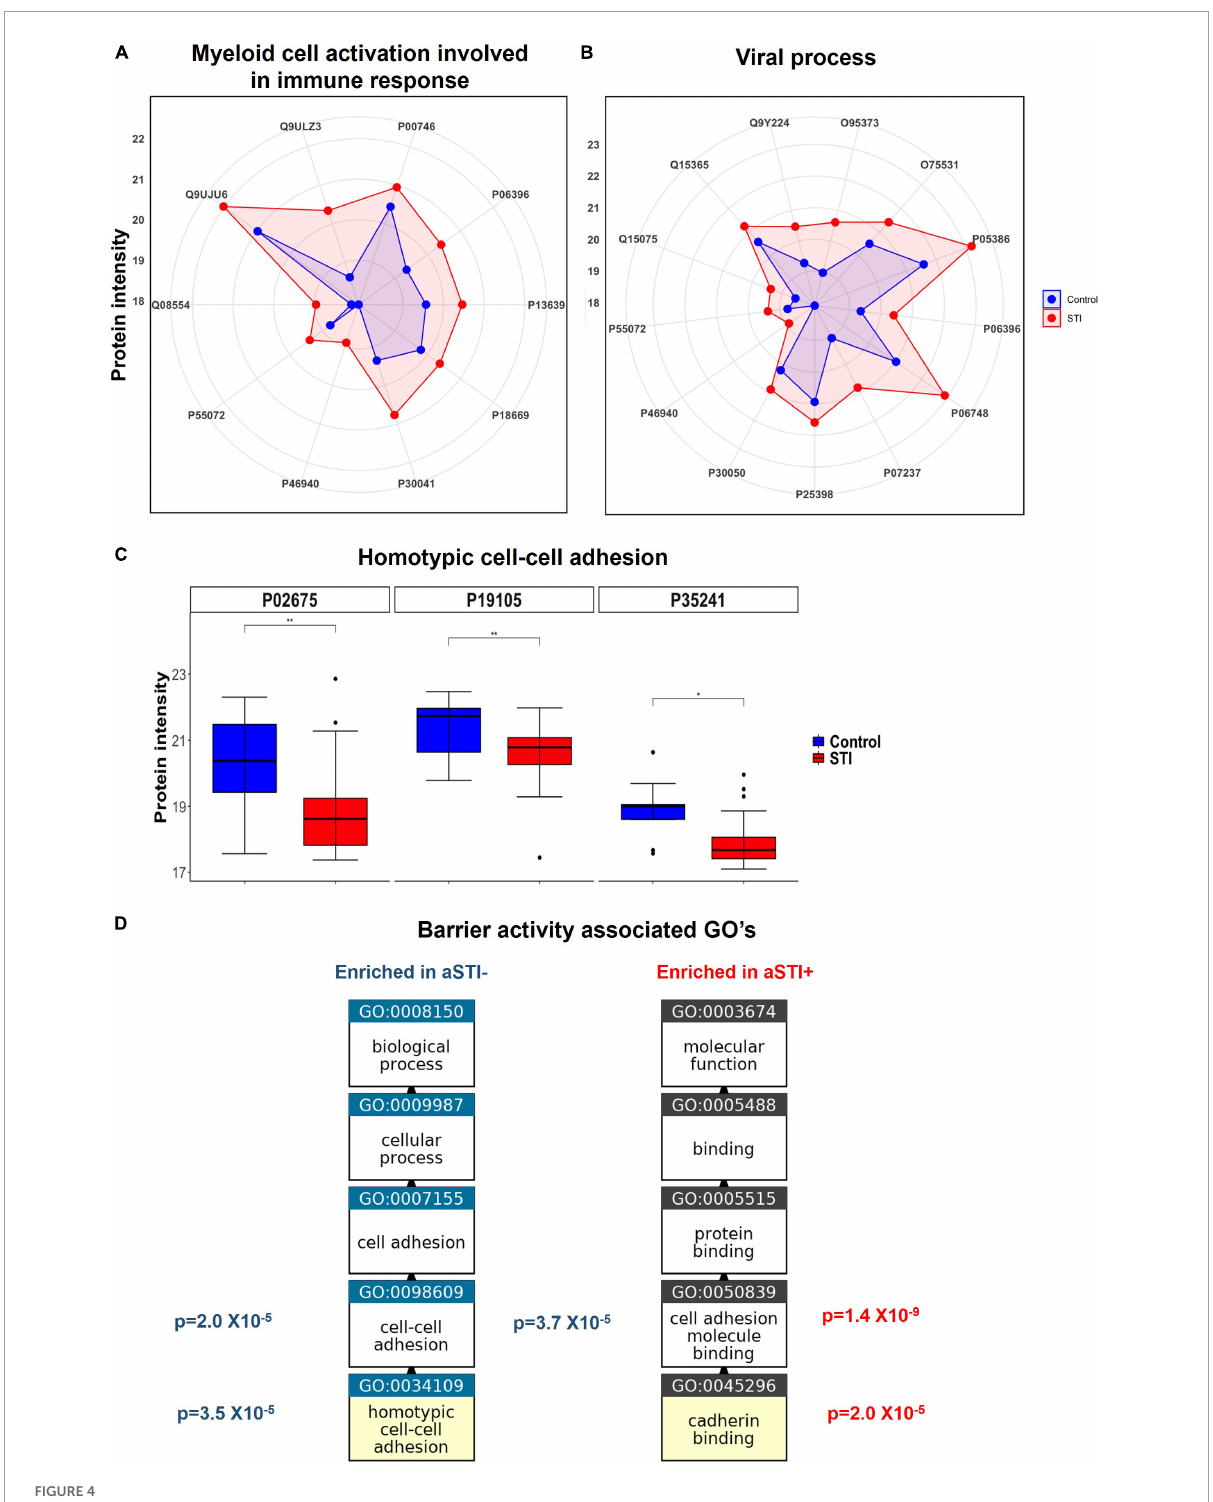
FIGURE4 Enriched immunological functions showing the impact of aSTI on protein functions enriched in aSTI proteomes compared to age-matched controls. (A) Radar plot showing the intensity of proteins in aSTI + foreskins (red area) and control foreskins (aSTI-) (blue) with related myeloid cell activation functions. Protein names are depicted by UNIPROT numbers for ease of annotation. (B) Radar plot showing protein intensity of proteins enriched in GOs related to viral immune response. (C) Box and whisker plots showing expression intensities of protein eliciting homotypic cell-cell adhesion protein function and their names. (D) Enriched GOs with barrier integrity function enriched in foreskin samples aSTI + (red) and aSTI-(blue) with their corresponding adjusted p -values of enrichment shown. GO flow diagram from